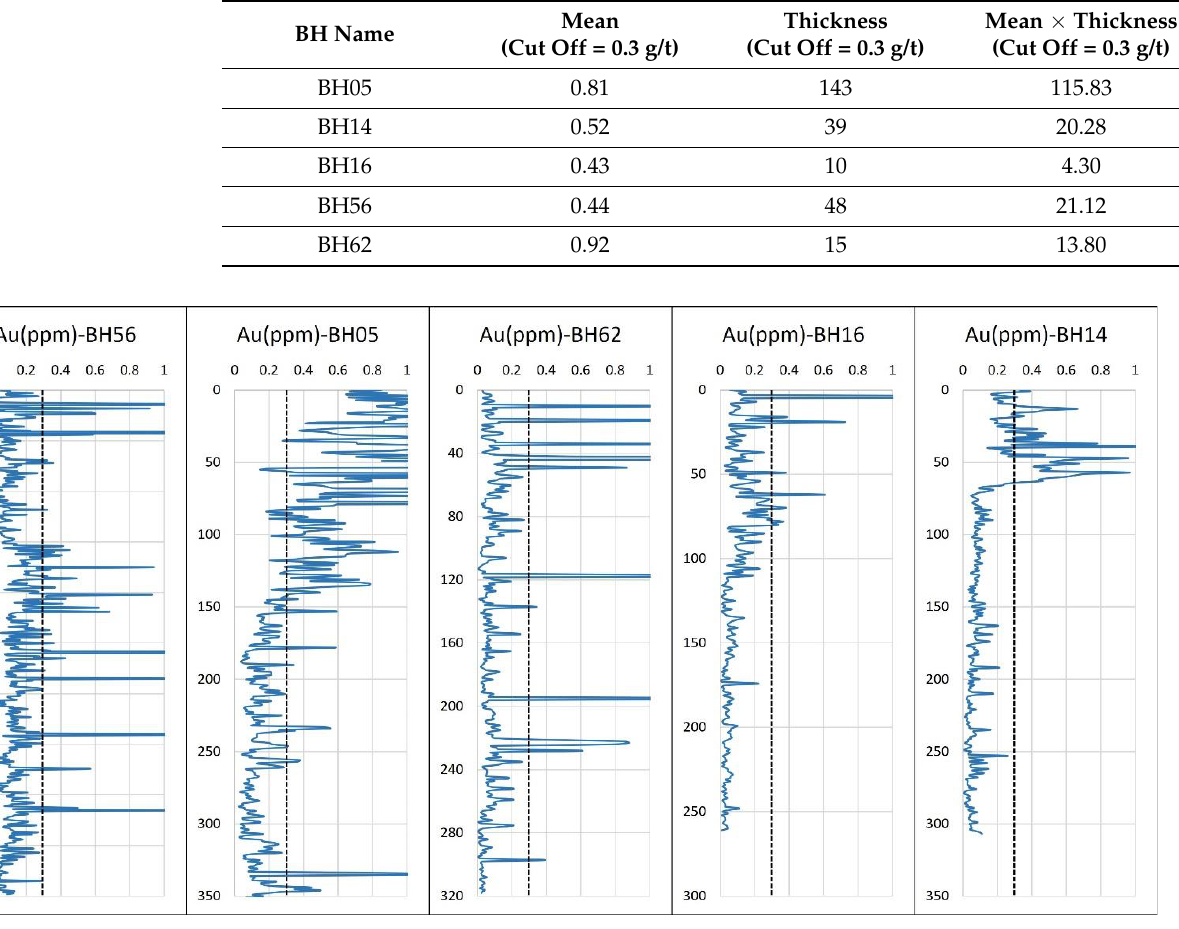
Figure 13. Gold grade (g/t) variation in boreholes drilled in potential zones. Dashed lines indicated economic cut-off value (Au = 0.3 g/t) for gold in the Shadan deposit.